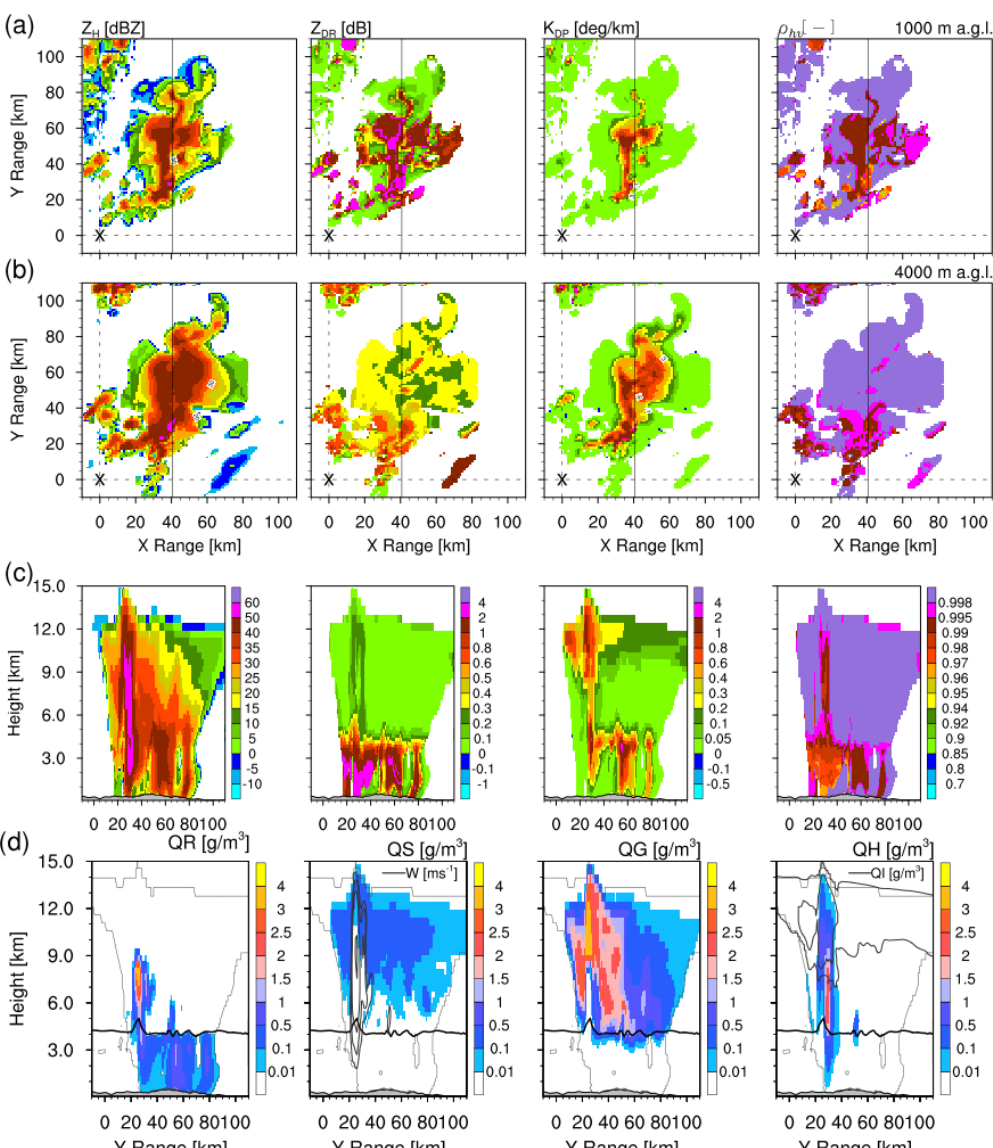
Figure 9. (a, b) Model-simulated horizontal reflectivity and differential reflectivity, specifically, the differential phase and cross-correlation coefficient at the low-level (1000ma.g.l.) and near-melting layer (4000ma.g.l.) on 5 July 2015 at 15:30UTC. The “x” symbol refers to the BoXPol location. The gray solid line indicates the location of the cross section. (c) Cross section of the same polarimetric variables. (d) Cross section of model-simulated hydrometeor density (QR is rain, QS is snow, QG is graupel, and QH is hail). Also shown is the 0 ◦ C line (solid black line) indicating the melting layer, contours of vertical velocity (5, 10, 20, 40ms − 1 ) with QS, and contours of cloud ice density (QI) with